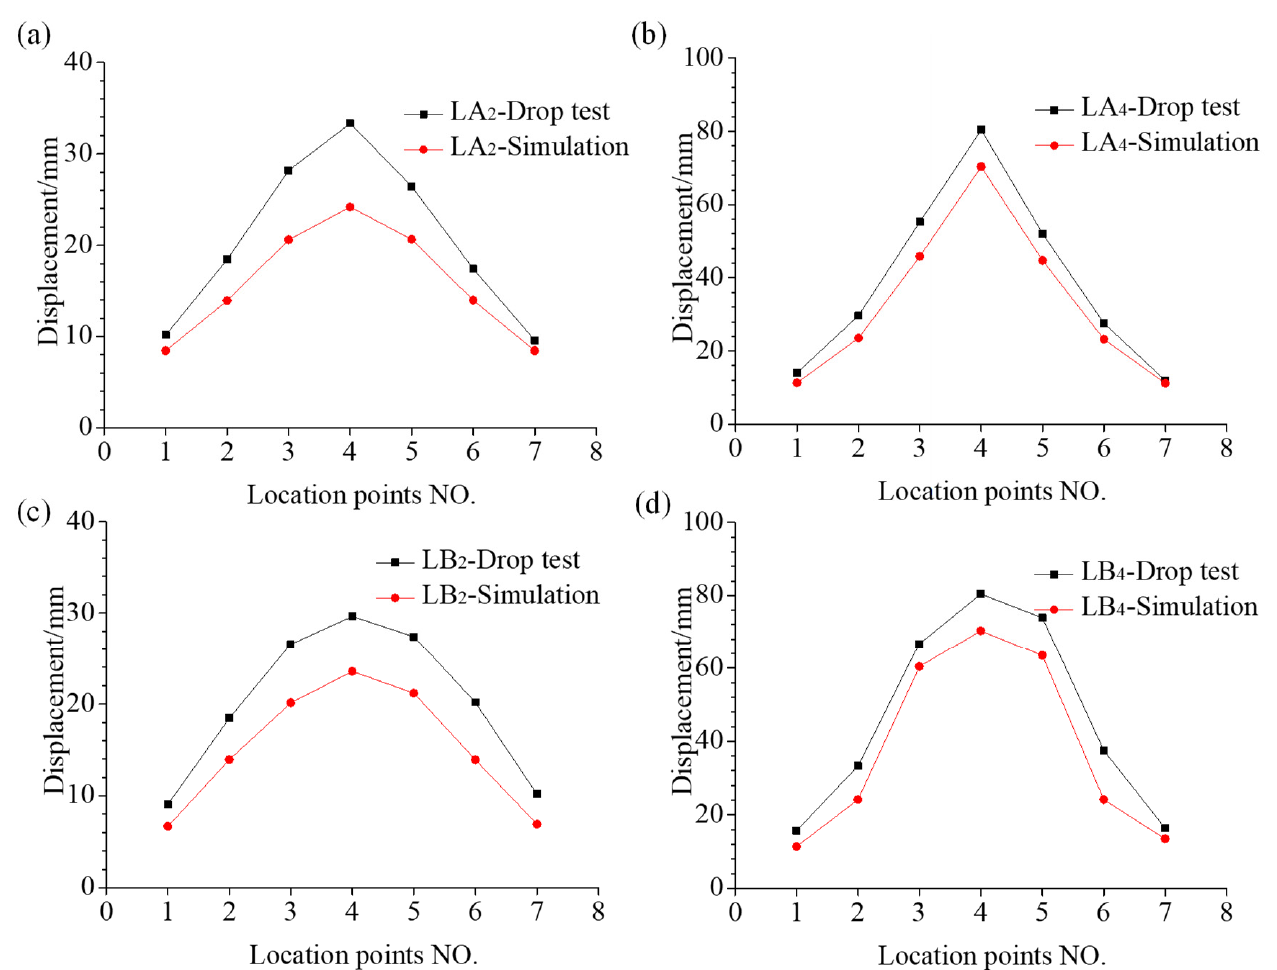
Figure 22. Comparison of deformation profiles between the experiment and simulation: ( a ) LA 2 ; ( b ) LA 4 ; ( c ) LB 2 ; ( d ) LB 4 .